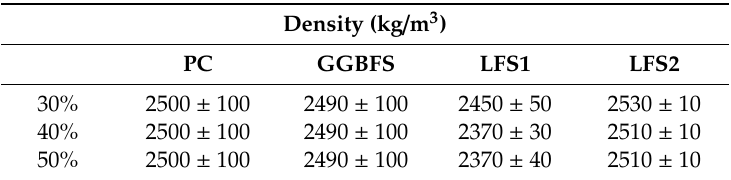
Table 3. Density of the